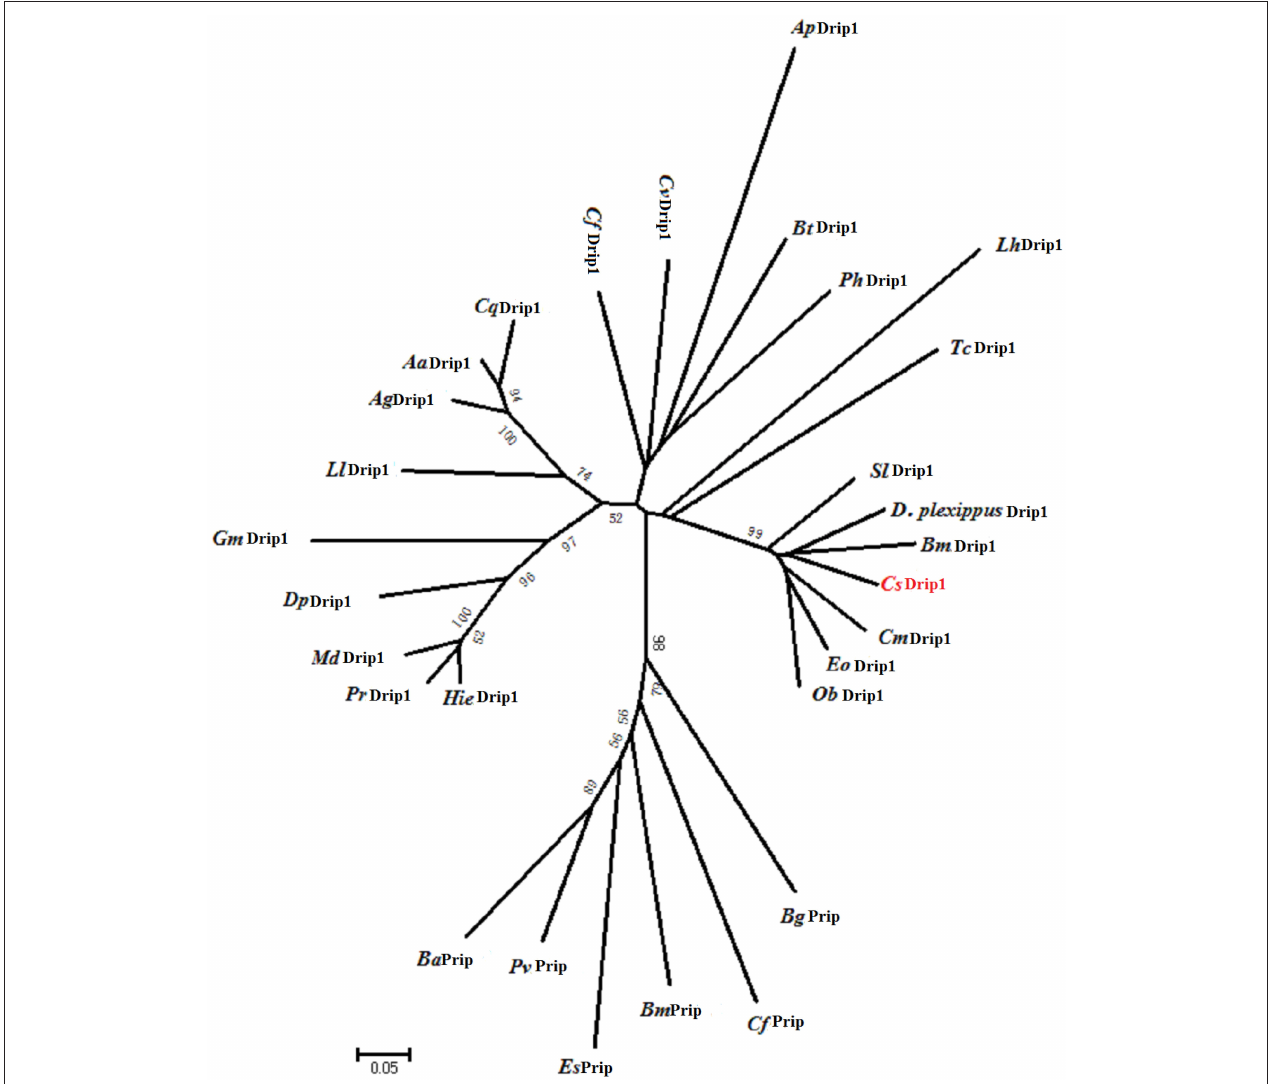
FIGURE 2 | Neighbour-joining phylogenetic tree showing the Chilo suppressalis Drip1 (JQ011314 and JQ011315) with respect to other insect AQPs. Bm Drip1 ( Bombyx mori , AB178640), Cm Drip1 ( Cydia molesta, AB469882), Aa Drip1 ( Aedes aegypti , AF218314), Ph Drip1 ( Pediculus humanus , DS235154), Tc Drip1 ( Tribolium castaneum , CM000285), Ll Drip1 ( Lutzomyia longipalpis , EU124628), Ag Drip1 ( Anopheles gambiae , AAAB01008984), Cf Drip1 ( Coptotermes formosanus , AB433197), Hie Drip1 ( Haematobia irritans exigua , U51638), Cv Drip1 ( Cicadella viridis , X97159), Dp Drip1 ( Drosophila pseudoobscura , CM000071), Bt Drip1 (